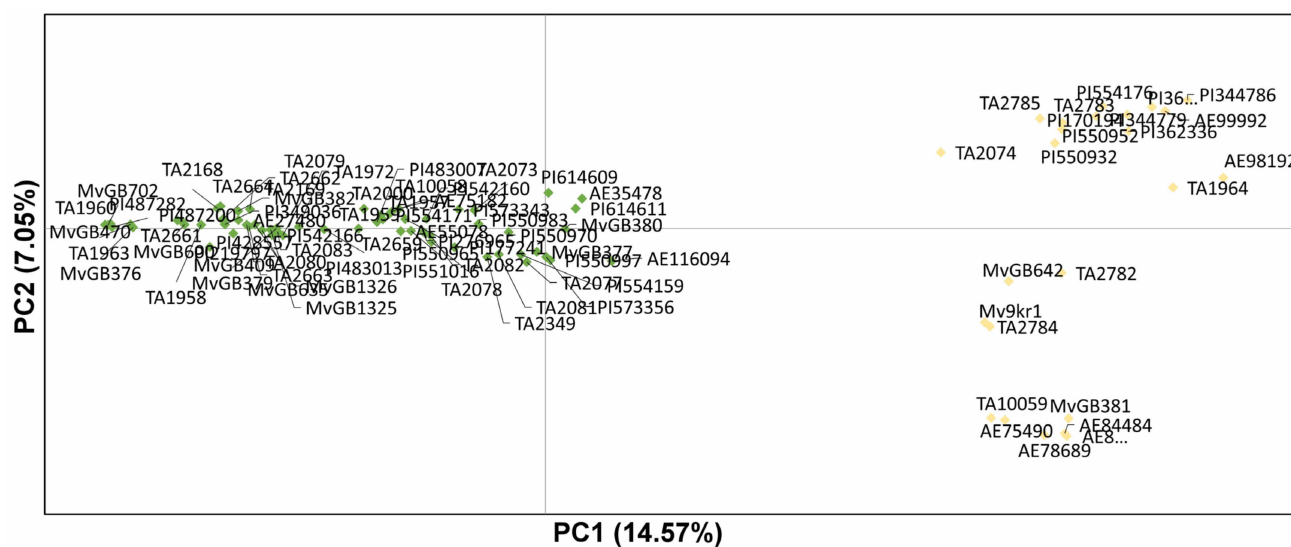
Figure 5. Principal Coordinate Analysis (PCoA) plot of the first two components obtained from the DArTSeq array of 2602 SNPs for 86 Aegilops accessions. The first two coordinates explained the 14.57% and the 7.05% of variability, respectively, for a total of 21.62%.